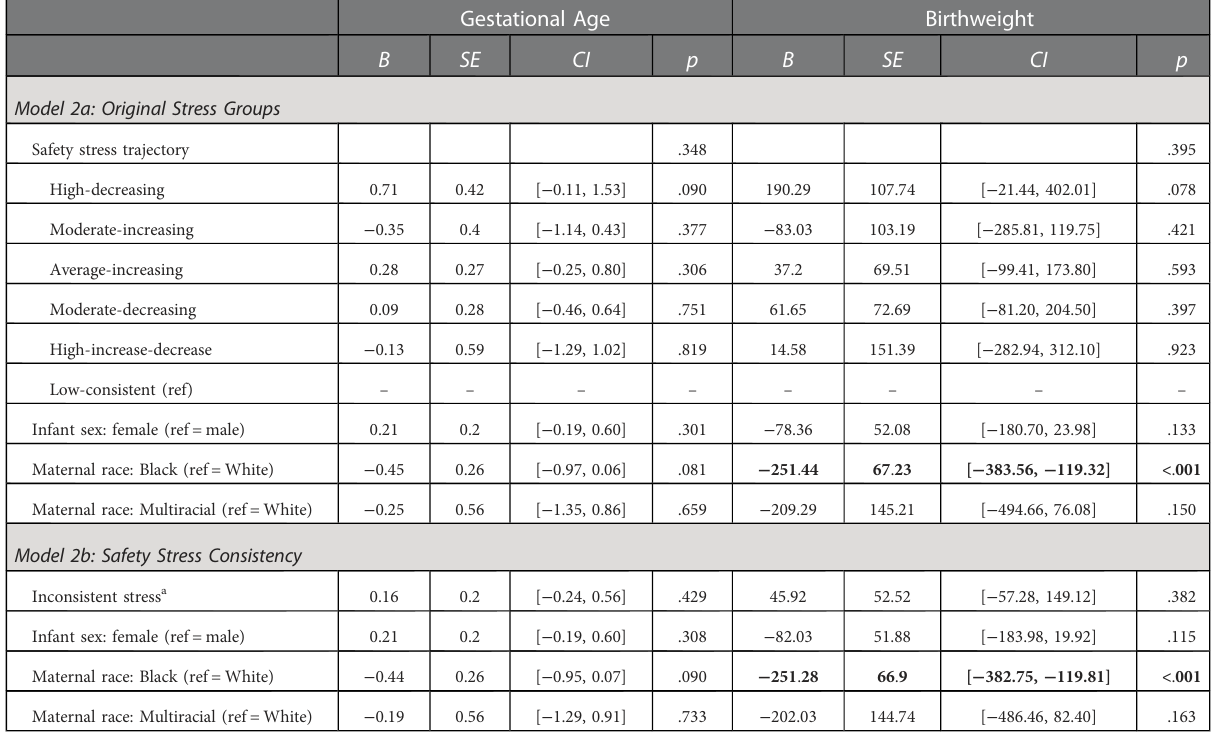
Table 5 . None of the original safety stress trajectories differed from the low-consistent trajectory reference group with respect to predicting either GA or birthweight ( Table 5 TABLE 5 Preconception exposure to safety stress predicting offspring birth